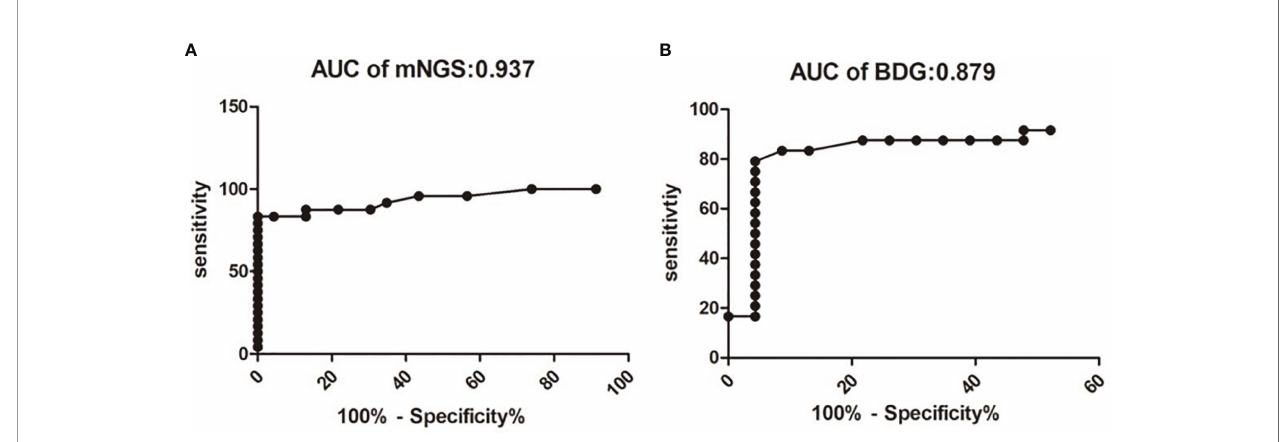
FIGURE 2 | Receiver operating characteristic curve for metagenomic next-generation sequencing (mNGS) and serum b-D-glucan assay for discrimination between Pneumocystis jirovecii pneumonia and Pneumocystis colonisation. The area under the curve value of mNGS is 0.937 (A) . The area under the curve value of mNGS is 0.879 (B) .